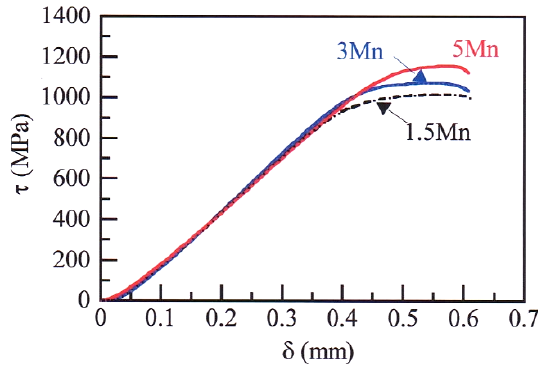
Figure 10. Typical shear stress-displacement ( τ - δ ) curves on hole-punching in 1.5Mn, 3Mn, and 5Mn steels subjected to the IT process at 370 ◦ C, 280 ◦ C, and 180 ◦ C, respectively. The IT temperatures are corresponding to M f + (30 ◦ C to 70 ◦ C).